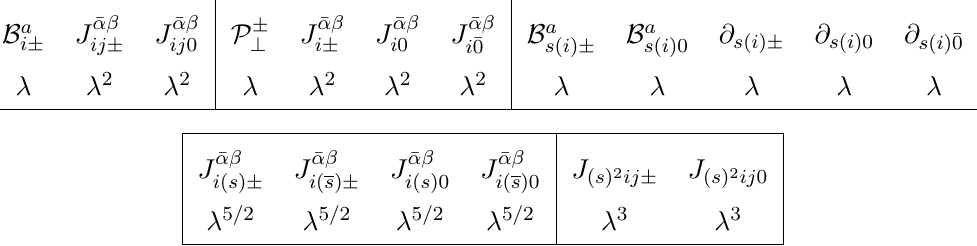
Table 3. Power counting for the full set of helicity building block operators in SCET II . Again we must add the conjugate currents J y in cases where they are distinct from the ones